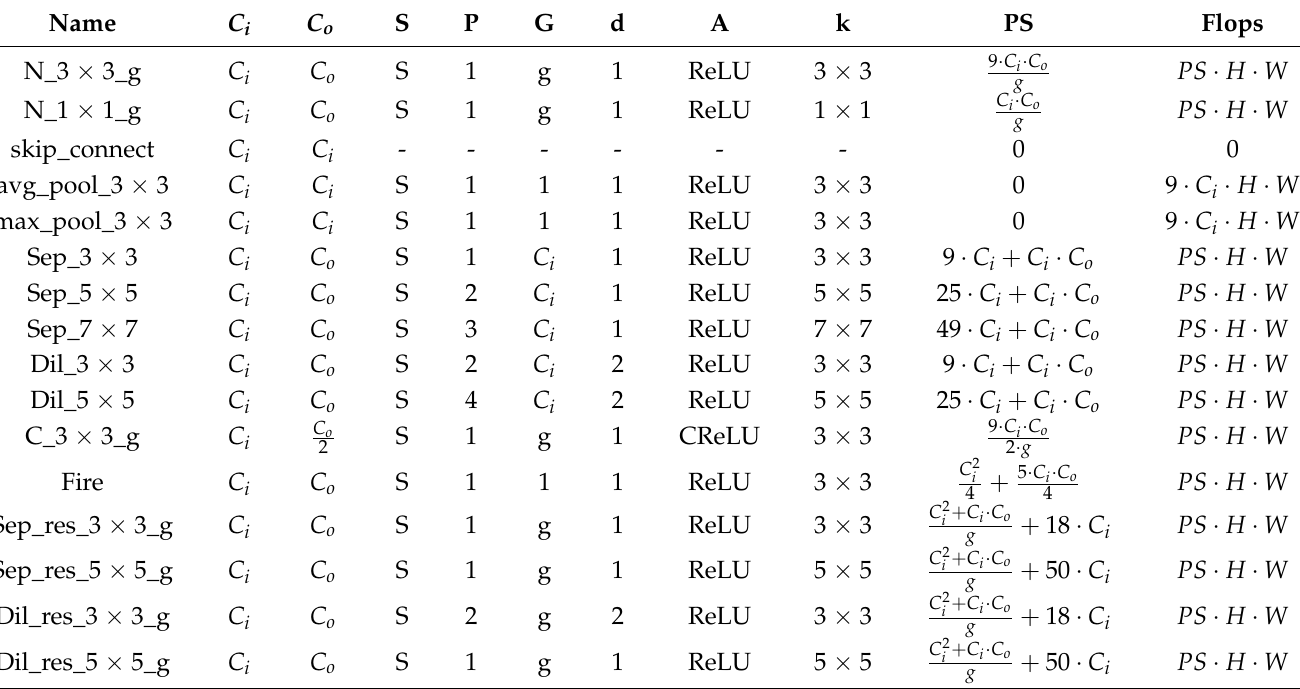
Table A1. Different operators used in our